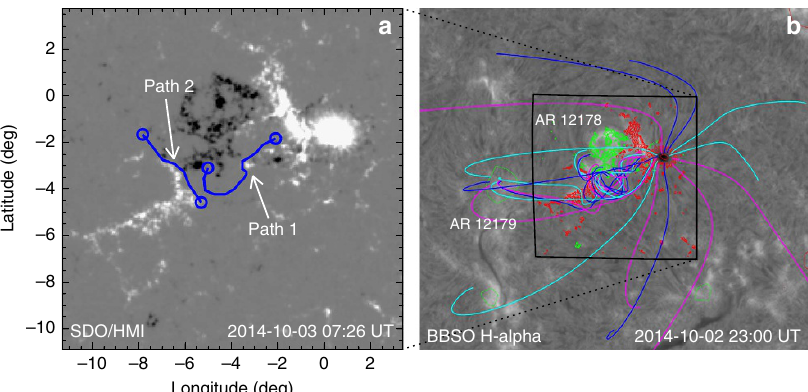
Figure 6 | Magnetic field model constructed using the Flux Rope Insertion method. ( a ) Line-of-sight magnetogram observed by SDO/HMI at 07:26 UT on 3 October 2014. The two blue curves with a circle at each end show the paths of the inserted flux ropes. ( b ) H-alpha image taken by Big Bear Solar Observatory at 23:00 UTon 2 October 2014, overlaid with red (positive) and green (negative) contours representing the magnetic field shown in a . The colour lines show selected field lines from the magnetic field model, and the horizontal size of the MHD computation box (height of 0.75 R } and fully within the high-resolution region) is indicated by the black